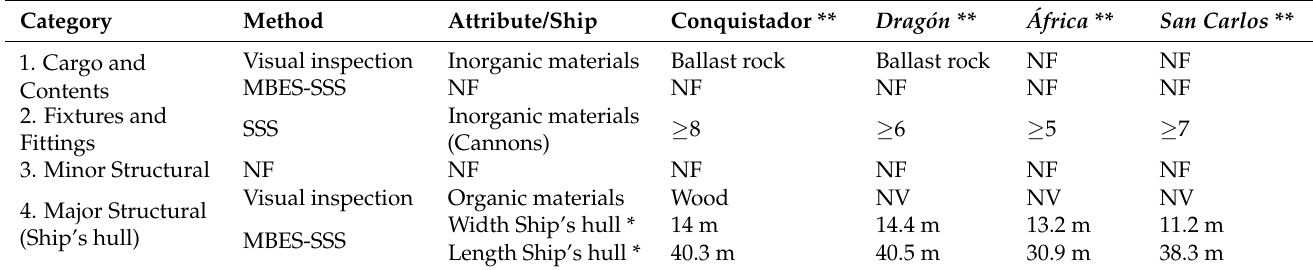
Table 6. Inventory of elements associated with the external context.